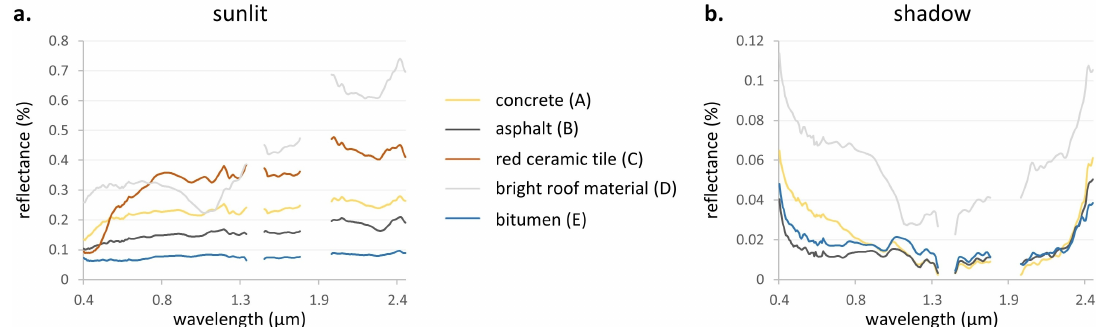
Figure 4. Examples of different material spectra sampled from the APEX image and included in the set of ground truth data with ( a ) sunlit spectra and ( b ) shaded spectra. Notice that the materials have been annotated in Figure 1b.